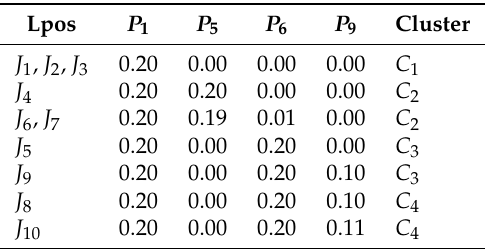
Table 1. Dictionary D 0.2 from network in Figure